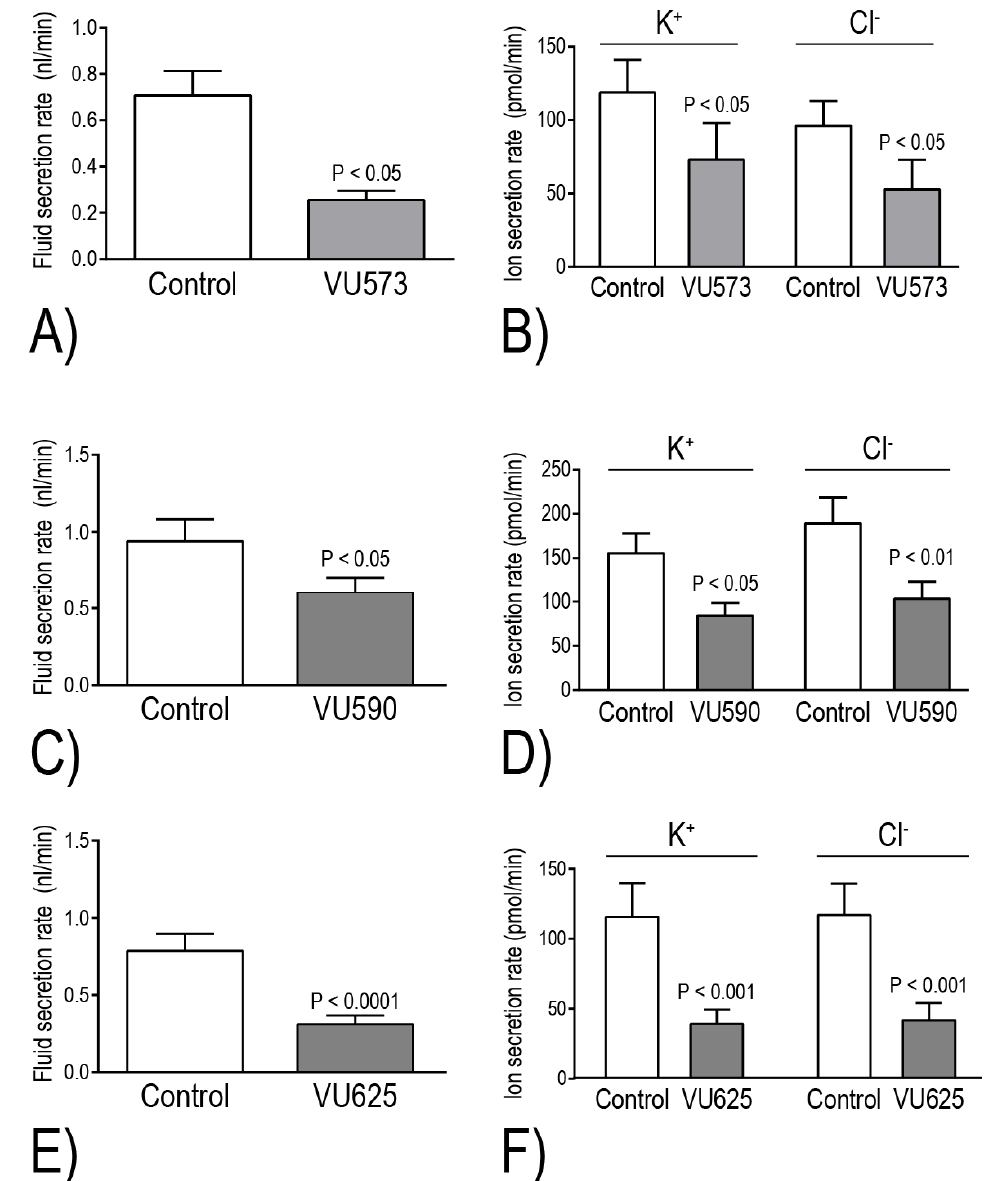
Figure 5. Effects of small molecule inhibitors of Ae Kir1 (10 μ M) on fluid ( A , C , E ) and KCl ( B , D , F ) secretion in isolated Malpighian tubules of Ae. aegypti as determined via the Ramsay assay. The experiments were performed on “sister” tubules isolated from the same mosquitoes. In the control tubules, 0.05% dimethyl sulfoxide (DMSO, the vehicle for small molecules) was added to the peritubular bath instead of the indicated small molecule. The secretion rates shown were measured 2 h after the addition of DMSO or the small molecule. Values are means ± SEM. Data are from [17,21]. To further test this possibility, we evaluated the effects of VU573, VU590, and VU625 on mosquito behavior/survival and excretory function. Notably, injection of each small molecule into the hemolymph of adult female Ae. aegypti elicits dose-dependent toxic effects within 24 h, manifested as death or a loss of flight [18–20]. Each of the molecules also reduces the whole mosquito capacity for diuresis, consistent with an inhibitory effect on the renal excretory system [18–21] (Figure 6A). Moreover, mosquitoes treated with VU573 are more susceptible to a hemolymph load of K + , which is likely a consequence of a decreased capacity for renal K + excretion [18,21]. Among the more dramatic renal effects that manifest in adult female mosquitoes after hemolymph injection of VU573 or VU590